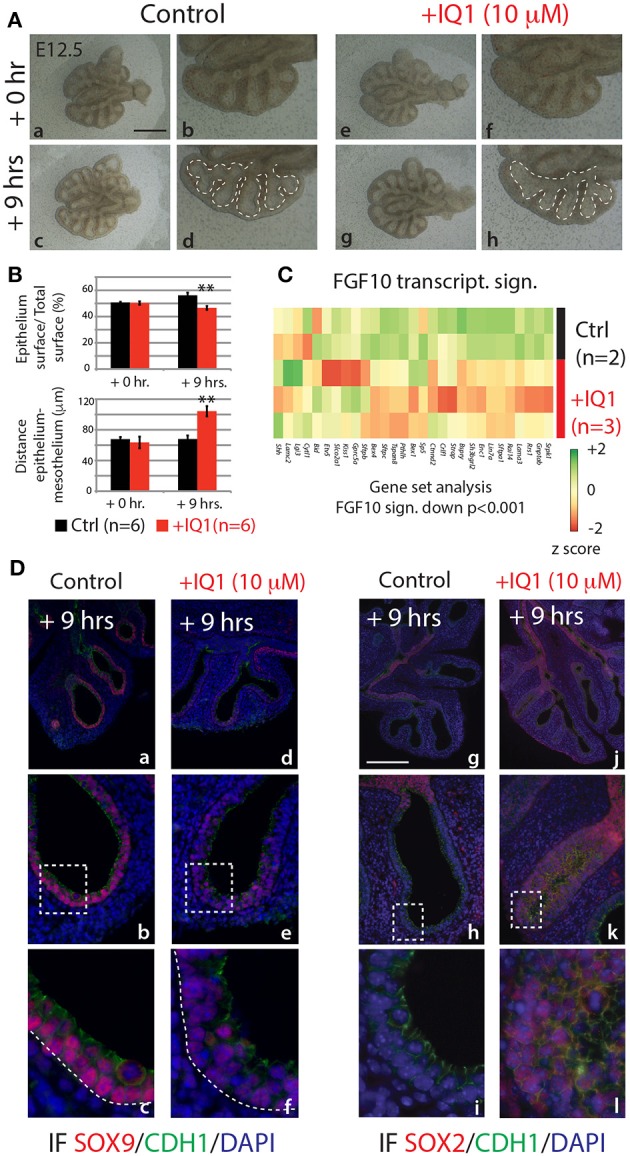
IQ1 treatment for 9 h phenocopies 9 h FGF10 inhibition (A) E12.5 lungs cultured with (experimental) or without (control) IQ1 for 9 h. Scale bar: (a,c,e,g) 500 μm; (b,d,f,h) 250 μm. (B) Quantification of branching defects showing a decreased relative epithelial surface and a concomitant increase in the distance between the epithelium and mesothelium. (Data are presented as mean ± SEM; significance determined by unpaired two-tailed Student's t-test; n = 6; **p-value < 0.01). (C) A heatmap of IQ1 lungs treated for 9 h vs. control showing the “FGF10 gene signature.” A gene set analysis demonstrates the significant down-regulation of this group of genes (n = 2 for control and n = 3 for experimental; see Materials and Methods for details on the statistical analysis of gene sets). (D) IF for SOX9 (a–f) and for SOX2 (g–l). Scale bar: (a,d,g,j) 300 μm; (b,e,h,k) 75 μm; (c,f,i,j) 45 μm.